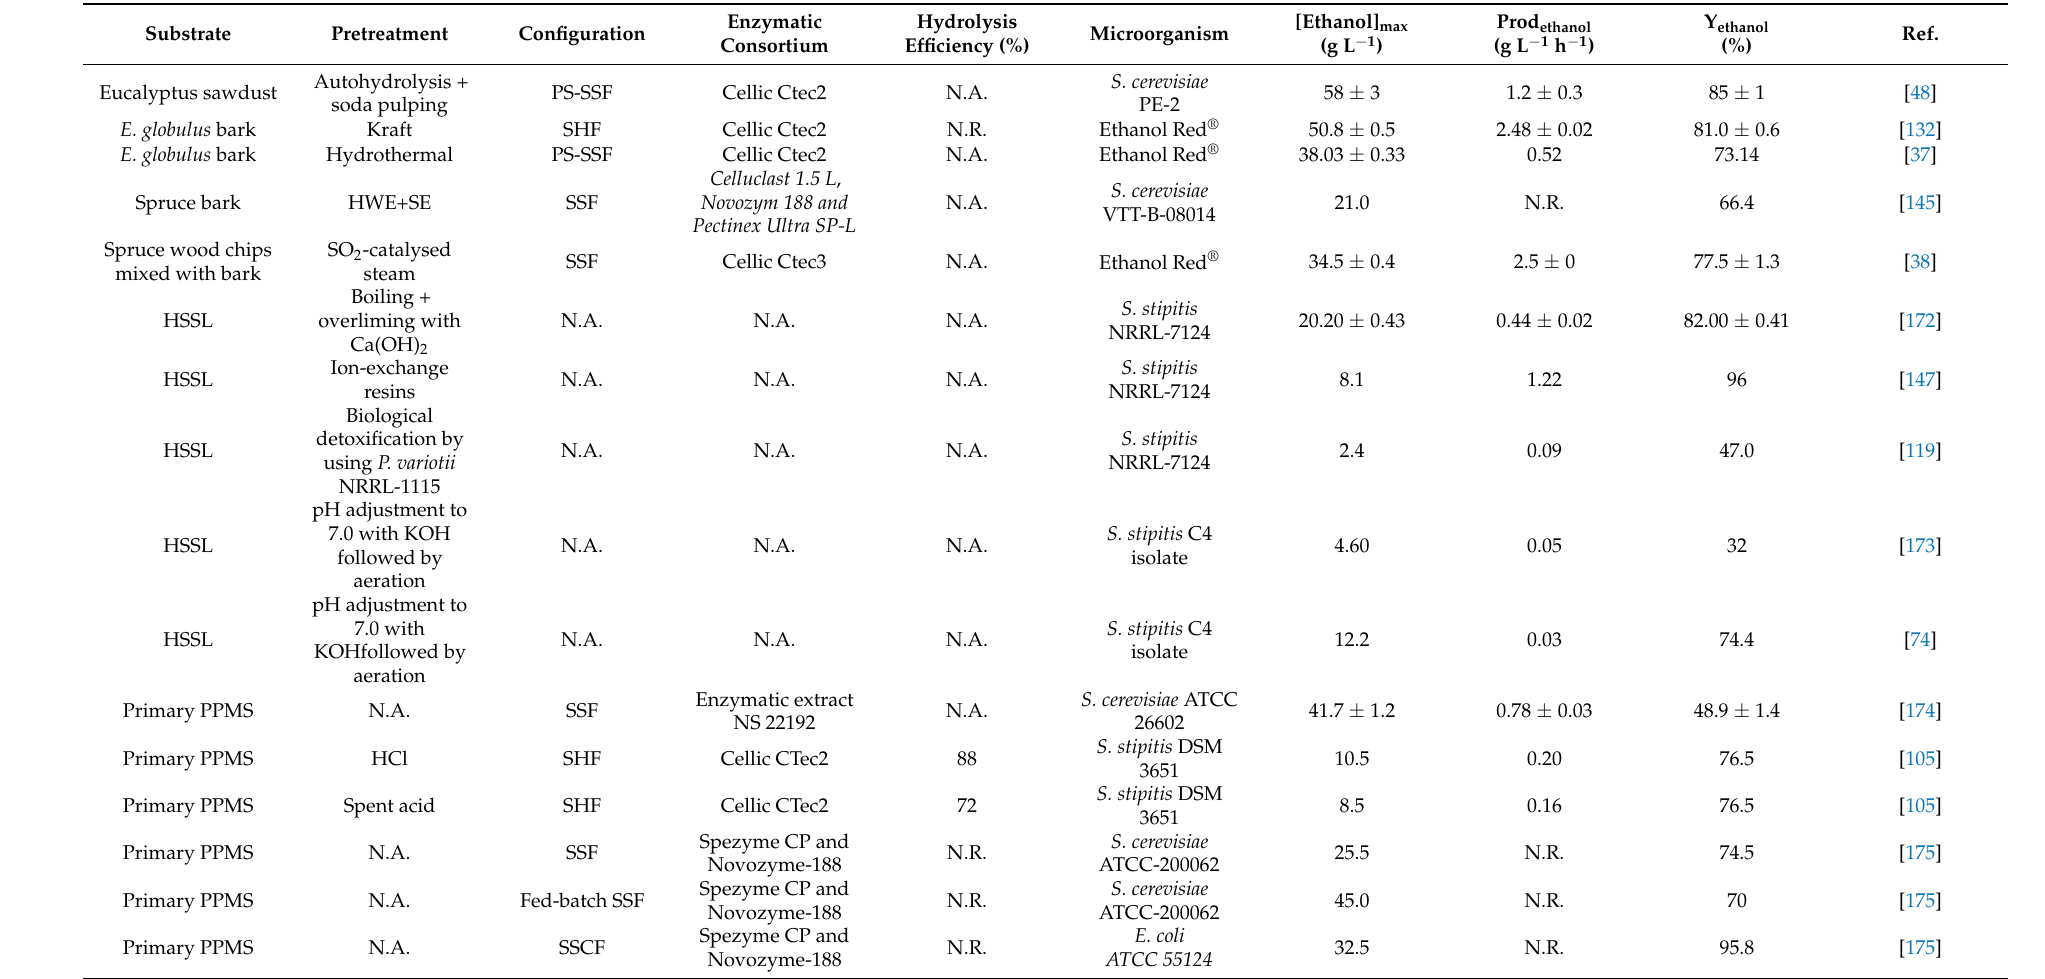
Table 1. Bioethanol production from pulp and paper